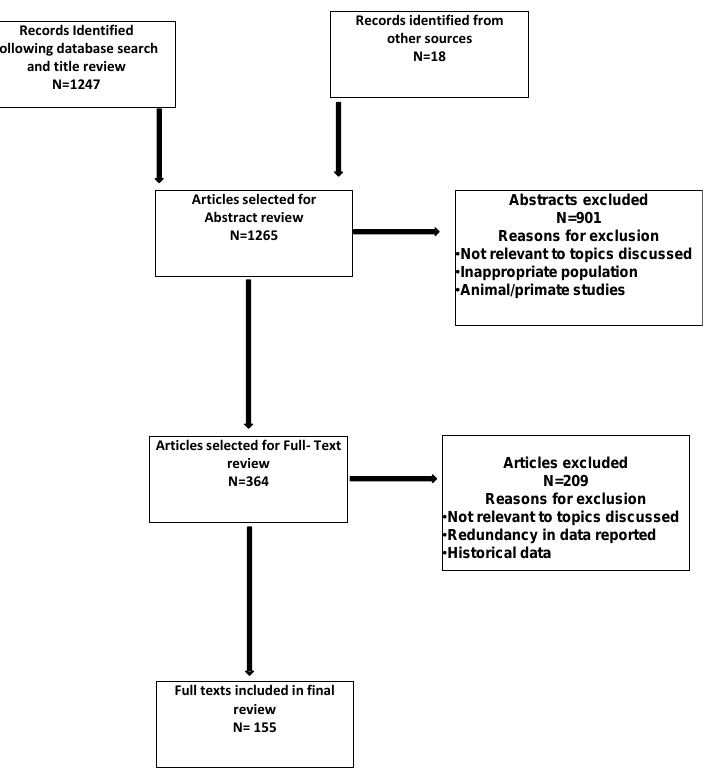
Figure 1. Flow chart of literature search.